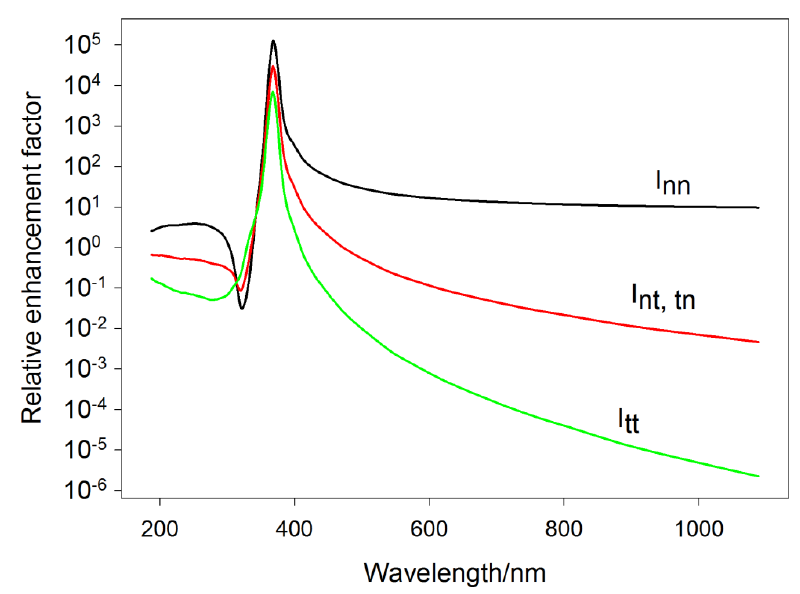
Figure 7. Calculated wavelength-dependent relative enhancement factor for molecules adsorbed in the vicinity of a small silver sphere for the three classes of Raman modes. 𝜀 𝑟 was assumed to be 1.33.